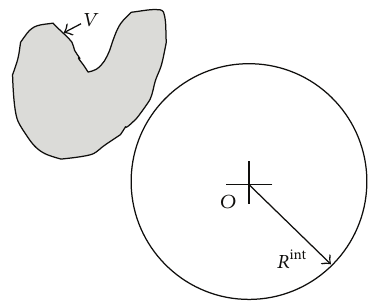
Figure 5: Illustration of an origin 𝑂 for which the support of the source 𝜌 is contained outside a ball of radius 𝑅 int centered at this origin.